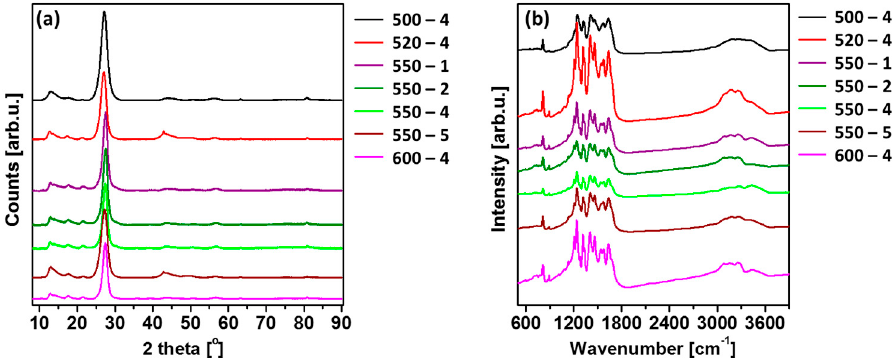
Figure 2. ( a ) X-ray diffraction (XRD) patterns; ( b ) Fourier transform infrared (FTIR) spectra of polymeric carbon nitride prepared under different conditions.